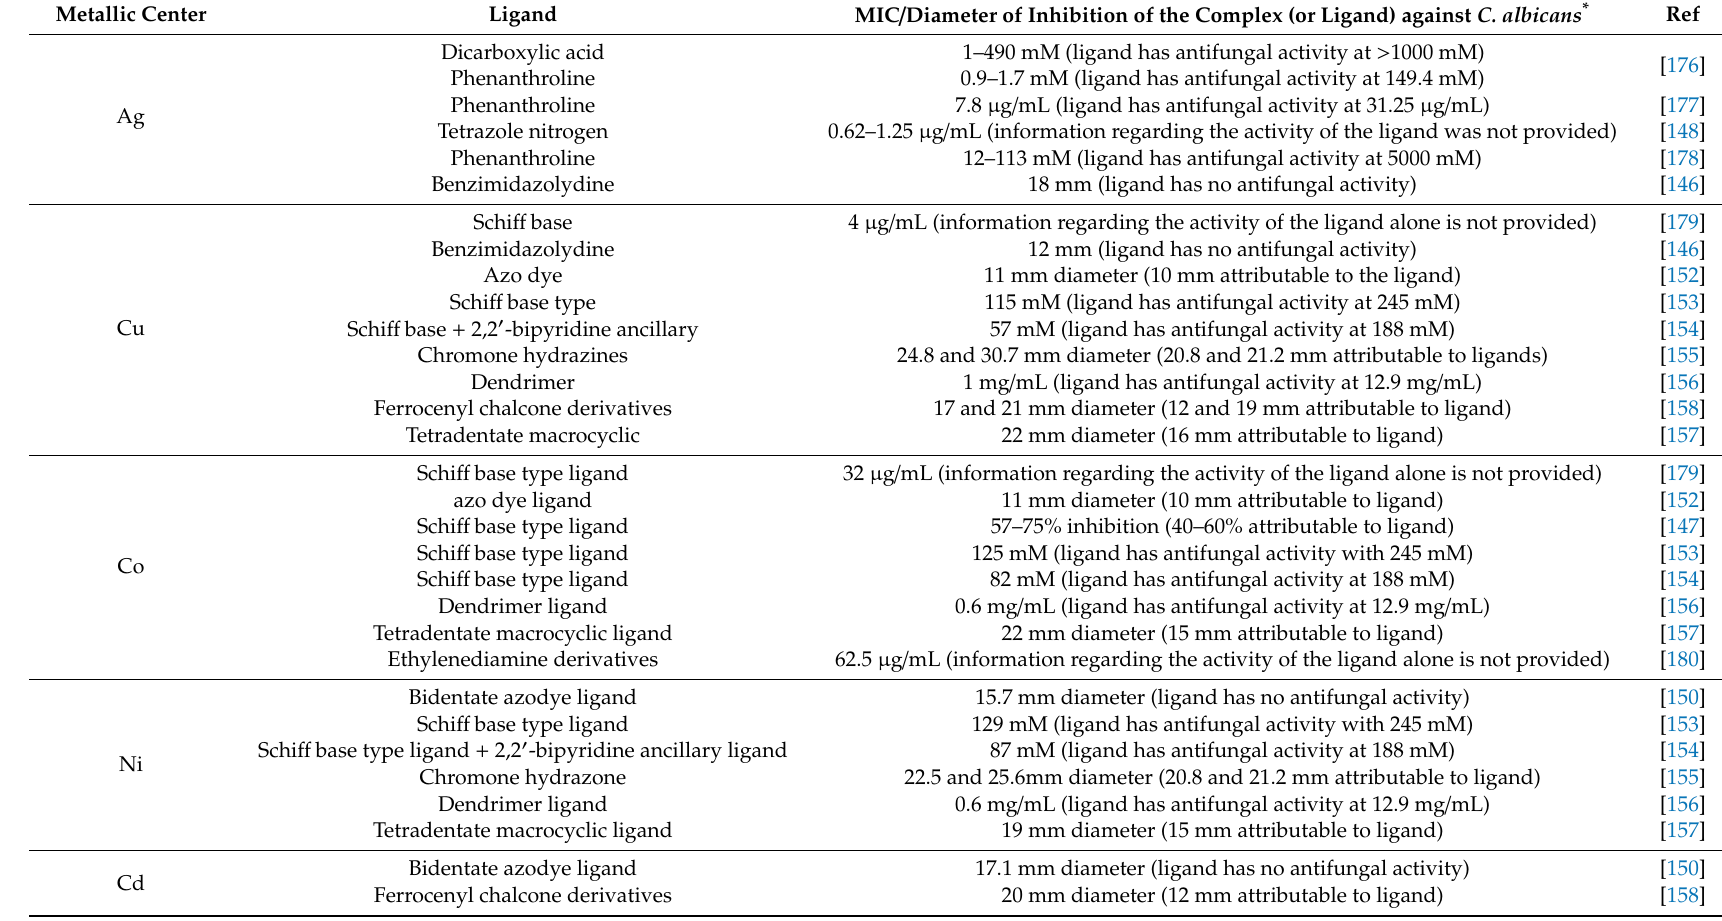
Table 5. Examples of reported complexes involving di ff erent metallic centers that were shown to exhibit interesting activity against C. albicans. Metallic